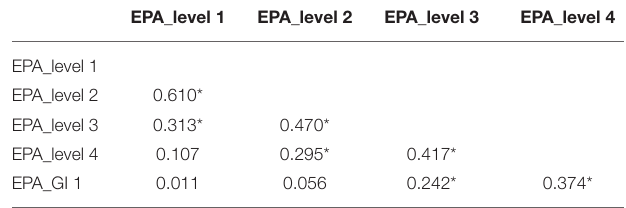
TABLE 6 | Association Co-efficients general EPAs-GI EPA 1 for